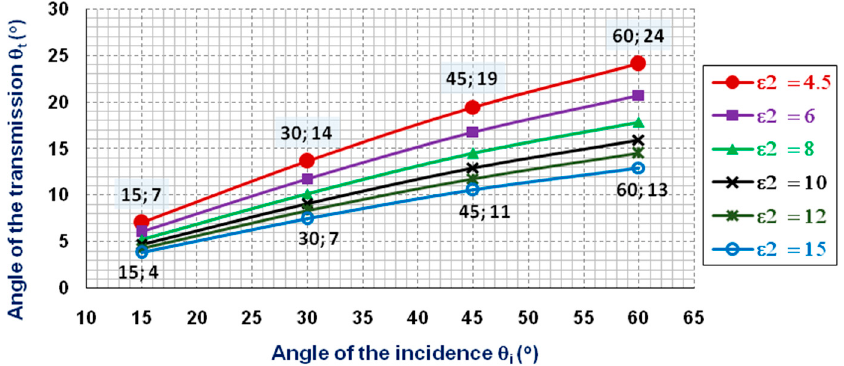
Figure 5. Angles of refracted waves ( θ t ) in the function of the incident waves ( θ i ) and the dielectric constant of the concrete ( ε 2 ).